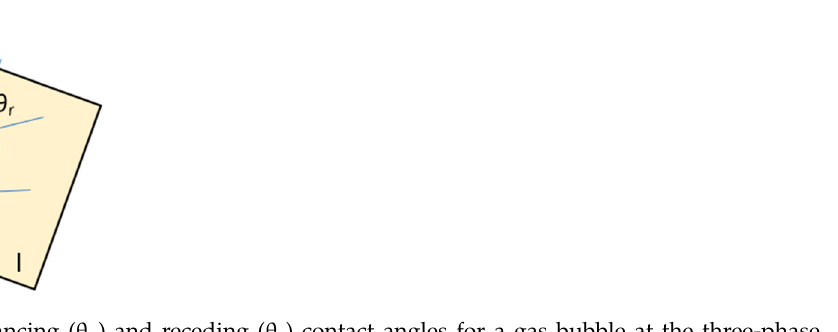
Figure 2. Advancing ( θ a ) and receding ( θ r ) contact angles for a gas bubble at the three-phase boundary where a liquid (l), gas (g), and solid (s) intersect.